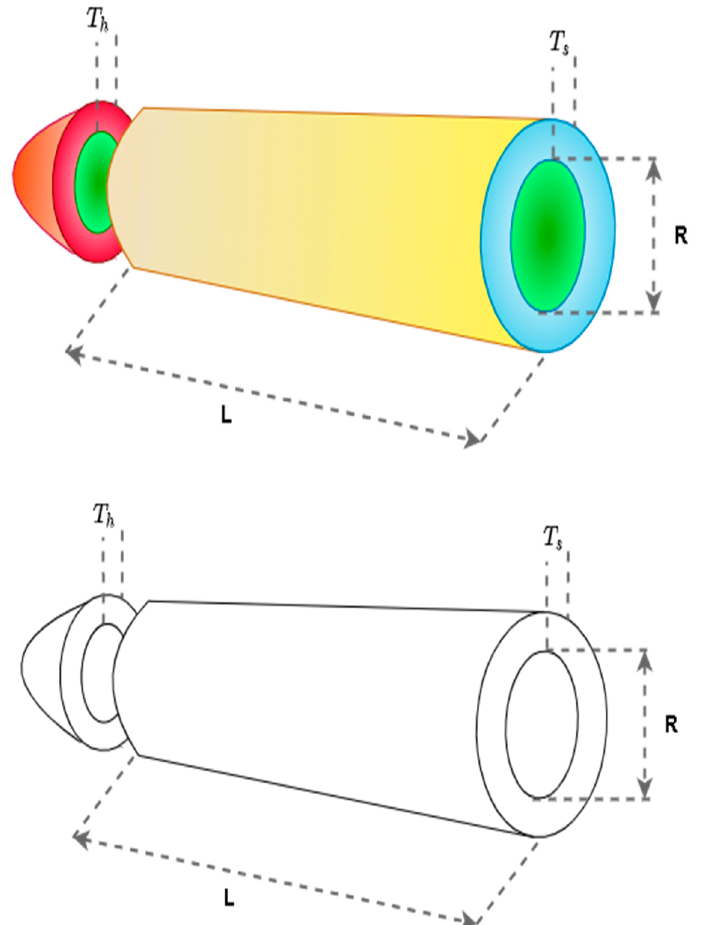
Figure 5. The PVD Figure 5. The PVD problem.